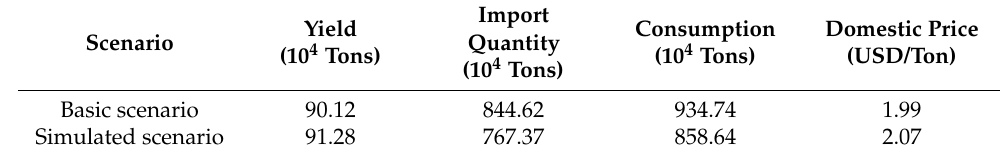
Table 10. Simulation results of changes in barley production and consumption in China (Scenario